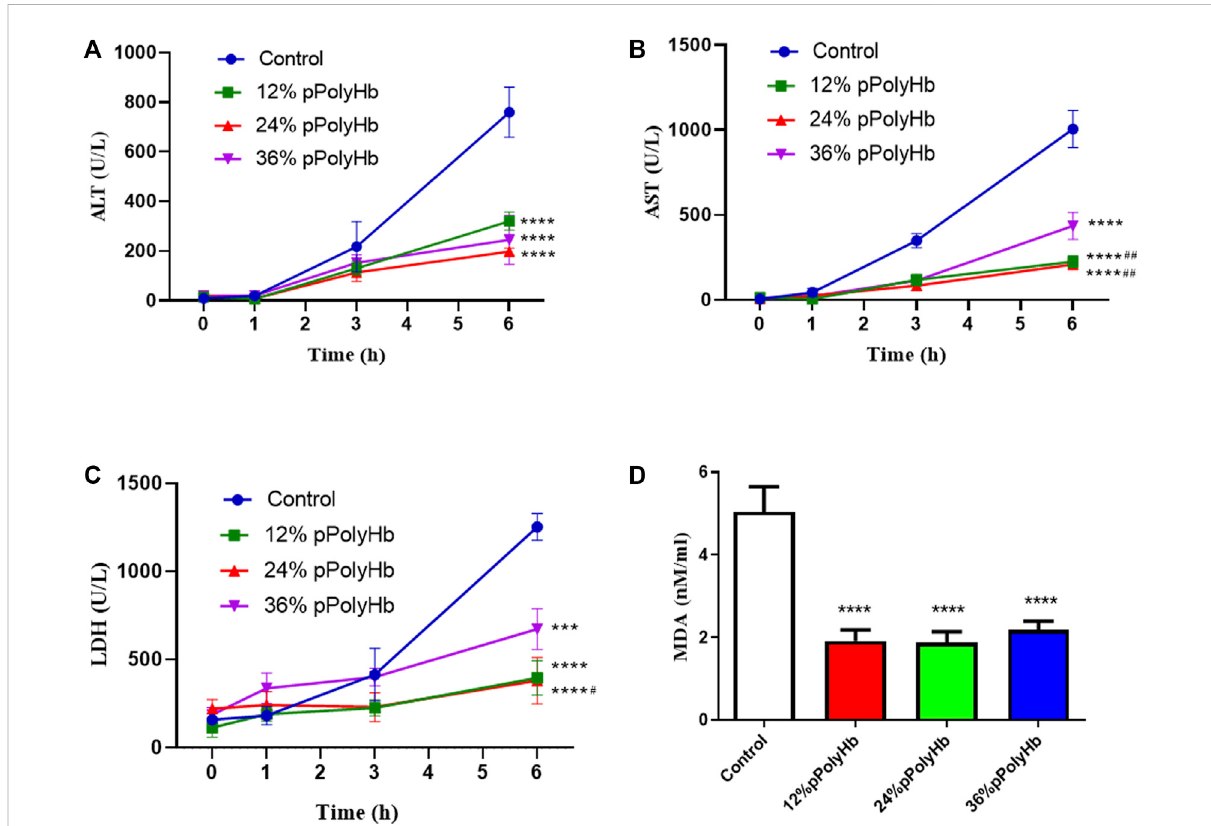
FIGURE 2 (A) After1 hofperfusion,thelevelsofALTinthethreegroupssupplementedwithpPolyHbweresigni fi cantlylowerthanthoseinbasalperfusate group (**** p < 0.0001) and the lowest level was found in the 24%pPolyHb group (B) After 1 h of perfusion, AST levels in three groups supplemented withpPolyHbweresigni fi cantlylowerthanthoseinbasalperfusategroup(**** p < 0.0001)andthegroupssupplementedwith12%pPolyHband24% pPolyHb was signi fi cantly lower than 36% pPolyHb group (## p < 0.01) (C) LDH values of three groups supplemented with pPolyHb were lower thanthoseofbasalperfusategroup (*** p < 0.001,**** p < 0.0001).The24%pPolyHbgroup wassigni fi cantly lowerthan36%pPolyHb(# p < 0.05) (D) MDA levels in basal perfusate group was signi fi cantly higher than that in pPolyHb group (**** p < 0.0001) (Note: * stands for comparison with the control group, # stands for comparison with 36% pPolyHb, * p < 0.05. ** p < 0.01, *** p < 0.001, **** p < 0.0001, #